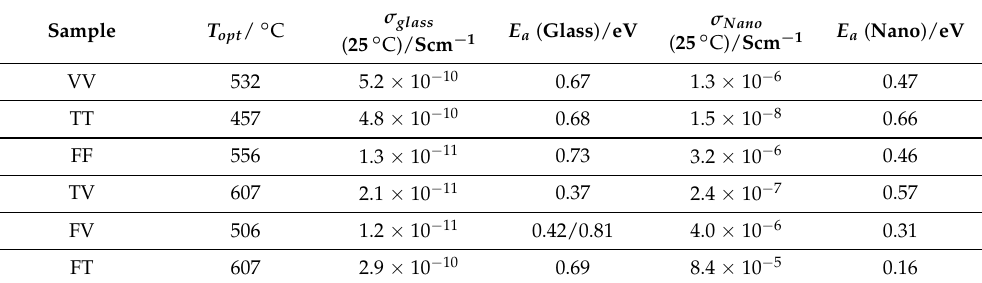
Table 3. Summary of total room temperature electrical conductivities of as-synthesized (glassy) and heat-treated (nano) samples. Conductivity values refer to Figure 3. Activation energies were determined from fitting parameters of Arrhenius Formula (1) to data in Figure 4. For each sample, optimal nanocrystallization temperature is given as